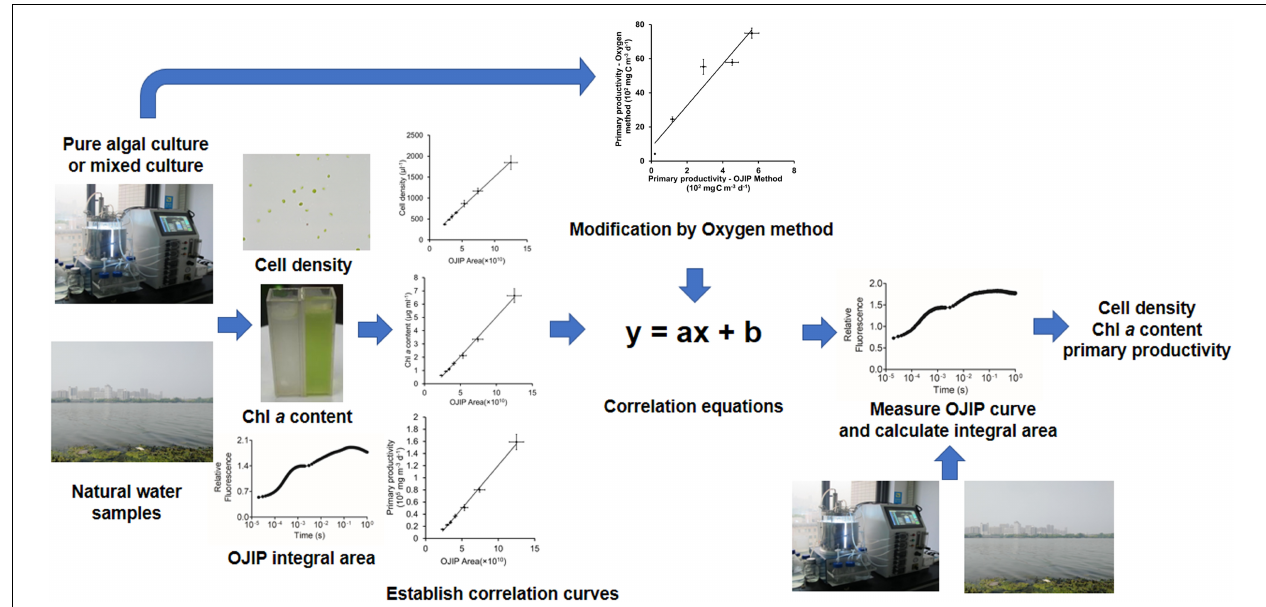
FIGURE 6 | Flow diagram for recommended application of the OJIP curve method for determining the cell density, Chl a content, and water primary